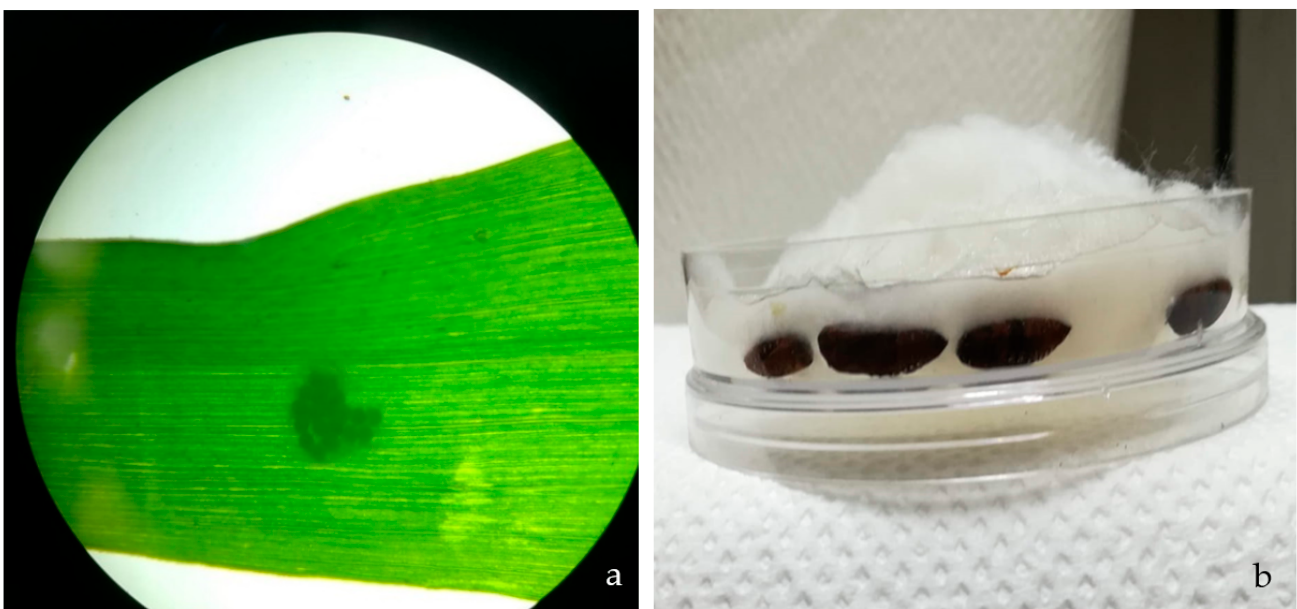
Figure 3. ( a ) Section of maize leaf containing fall armyworm eggs that have been sprayed with rabbit urine and ( b ) pupal immersed in rabbit urine before incubation for adult emergence assessment.